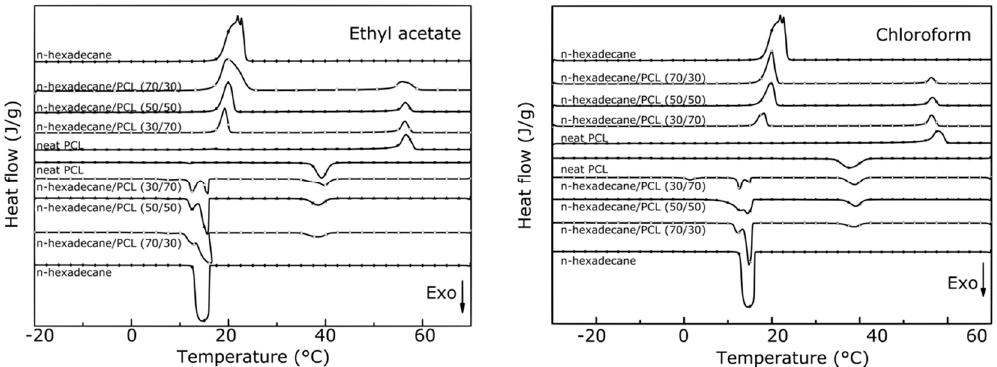
Figure 3. DSC cuves of n -hexadecane, neat PCL microspheres and a series of n -hexadecane/PCL microcapsules obtained from different solvents with different mass ratios between n -hexadecane and PCL.